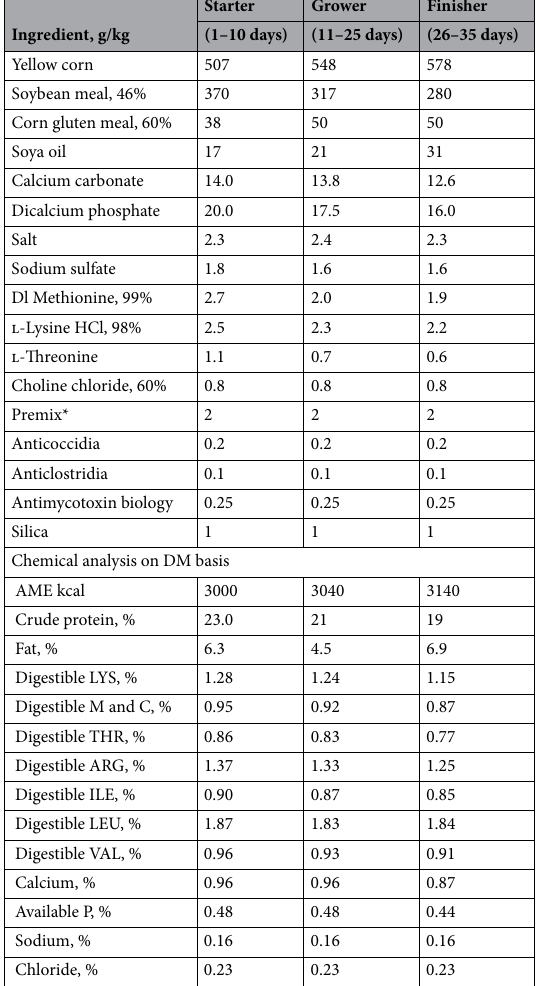
Table 1. Composition of the experimental starter, grower, and finisher diets. *Hero mix® (Hero pharm, Cairo, Egypt). Composition (per 3 kg): Vitamin A 12,000,000 IU, vitamin D3 2,500,000 IU, vitamin E 10,000